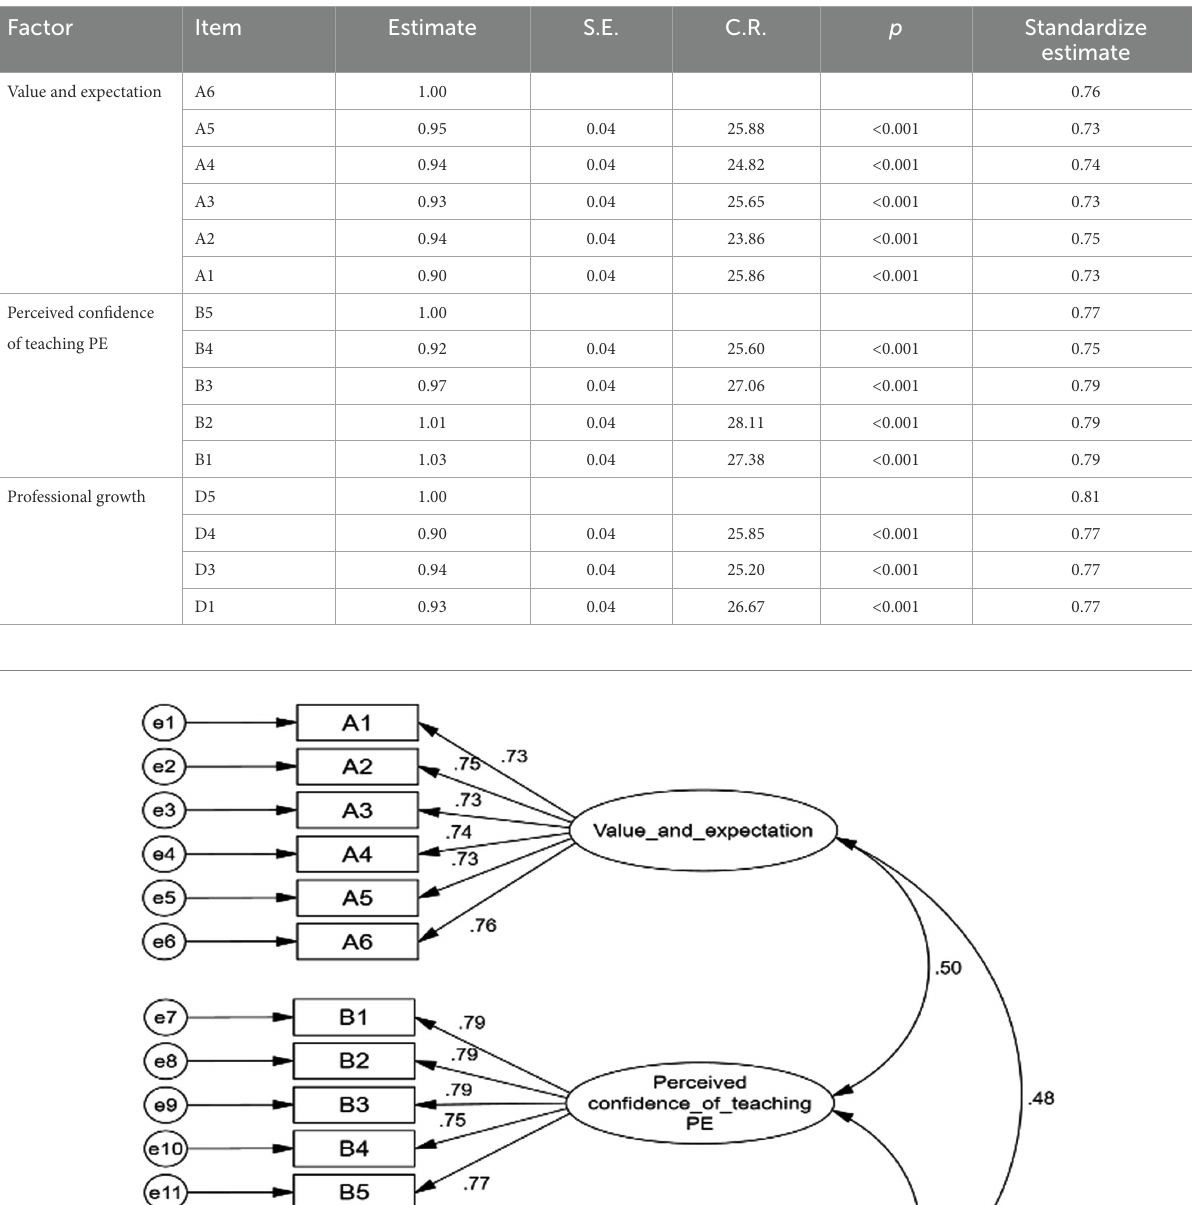
TABLE 5 Factor loadings of the three-domain scale.